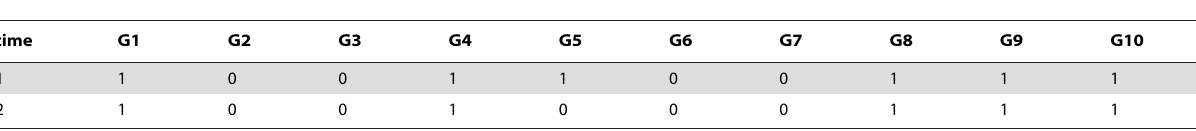
Table 10. First time trajectory after discretization (t=500 to t=1000).